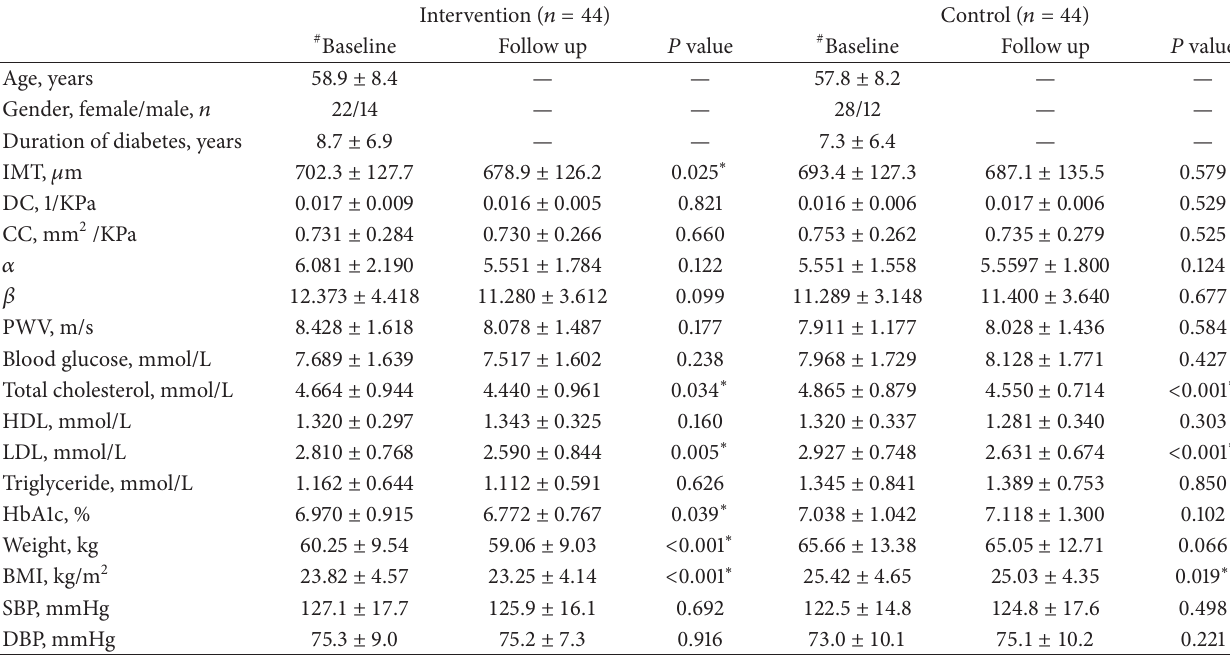
Table 2: Comparison of ultrasound parameters of the carotid artery and metabolic markers between the baseline and follow-up assessments in the intervention and control